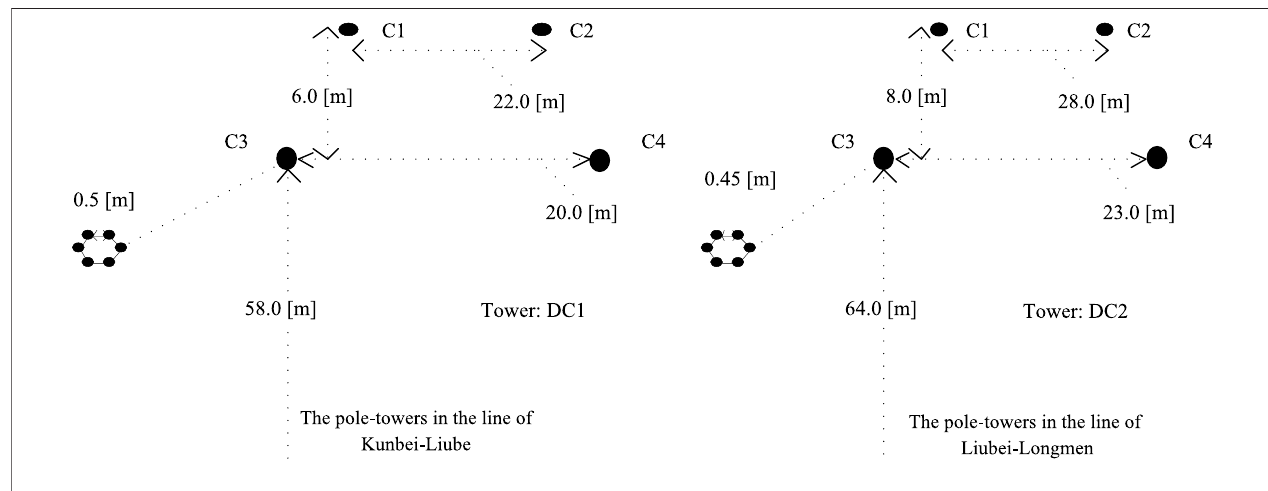
FIGURE 4 | Model and parameters of transmission line towers of Wudongde transmission